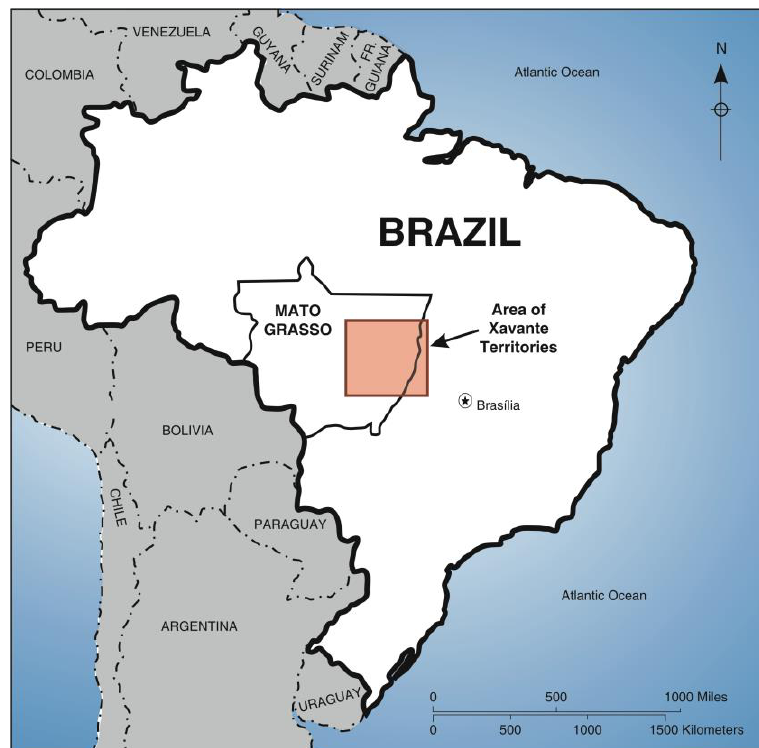
Figure 1 . Location of Xavante territories. Source: Courtesy of Graham, Hernández and Waiassé (2009).